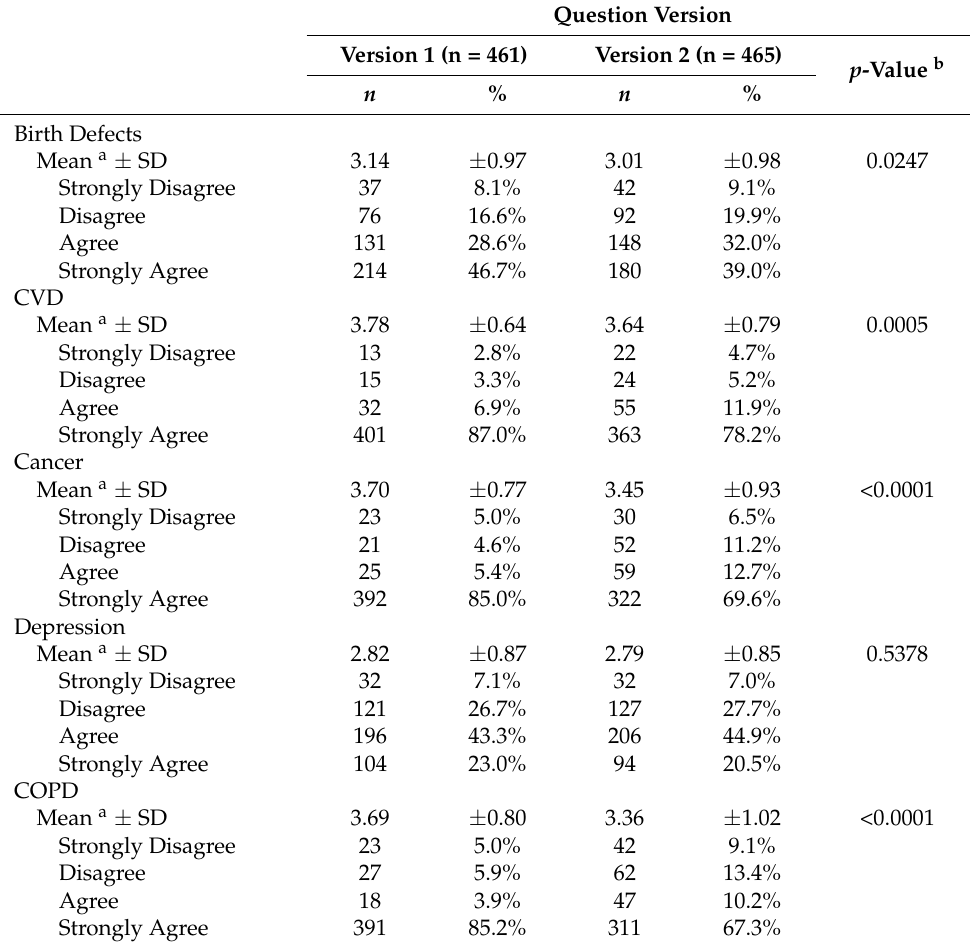
Table 2. Distribution of Responses to Nicotine Questions, by Question Version (N =